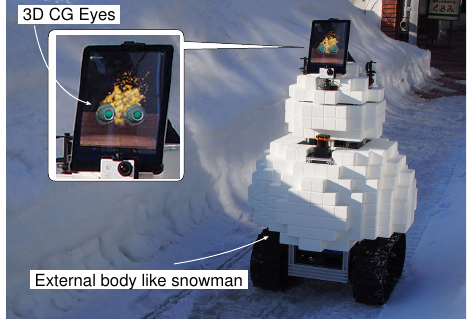
Figure 1. Information service robot on a